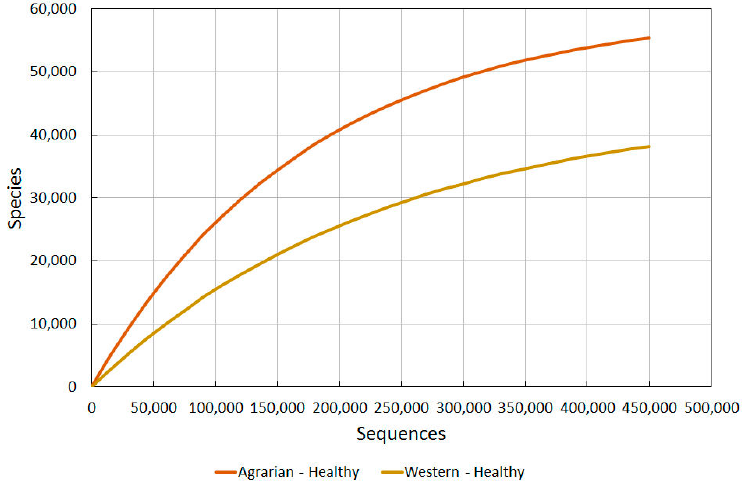
Figure 3. A comparison of bacterial diversity in healthy agrarian and healthy western skin. Rarefaction analysis using Chao1 3% index.